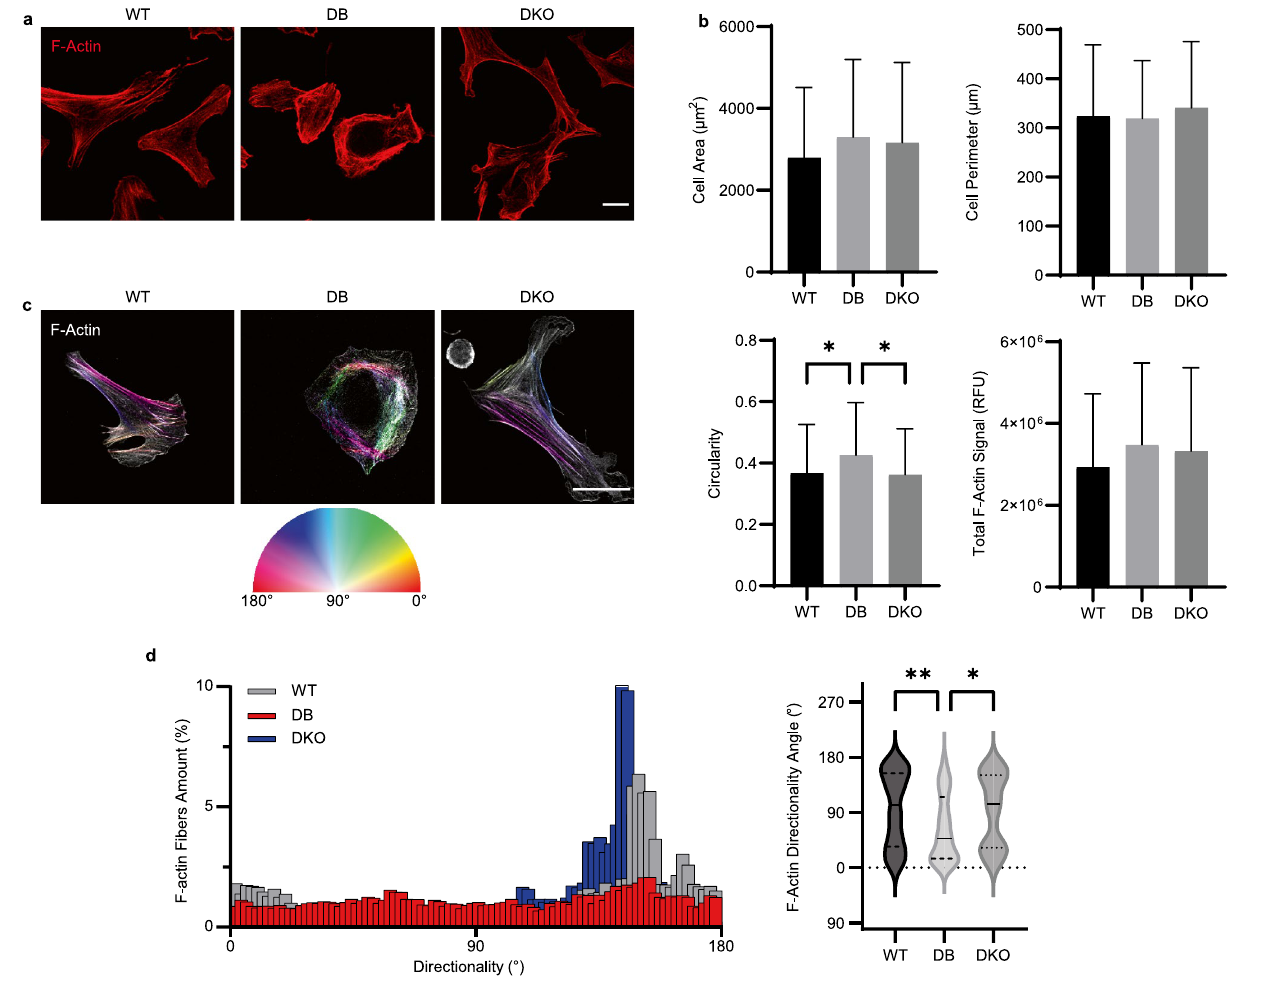
Figure 1. DB primary dermal fibroblasts exhibit rounded morphology. ( a ) Confocal images of WT, DB, and DKO dermal fibroblasts stained for F-actin (rhodamine phalloidin) show differences in cell shape. Scale bar is 20 μm. ( b ) Quantifications of cell area, perimeter, circularity, and total F-actin signals show rounded morphology of DB dermal fibroblasts compared to WT and DKO cells while maintaining a similar level of actin expression. One-way ANOVA followed by Tukey’s post hoc test and multiple comparison test (n animals = 3 per genotype, n cells = 30 per animal). *p < 0.05. ( c ) Representative grey scale images of F-actin overlayed with fiber direction show less directed F-actin bundles in DB cells compared to WT and DKO. Scale bar is 40 μm. d Representative histograms of fiber directionality across three groups. Measurements of F-actin directionality angle reveal lower directionality angles in DB dermal fibroblasts. One-way ANOVA followed by Tukey’s post hoc test and multiple comparison test (n animals = 3 per genotype, n cells = 20 per animal). **p < 0.01, *p < 0.05. – represents mean and -- represents the 25th and 75th gested that DB fibroblasts might experience a dynamic shift from stress fibers to cortical actin. In contrast, WT fibroblasts displayed spindle-shaped morphology that is conventionally observed in fibroblast cell lines, and is